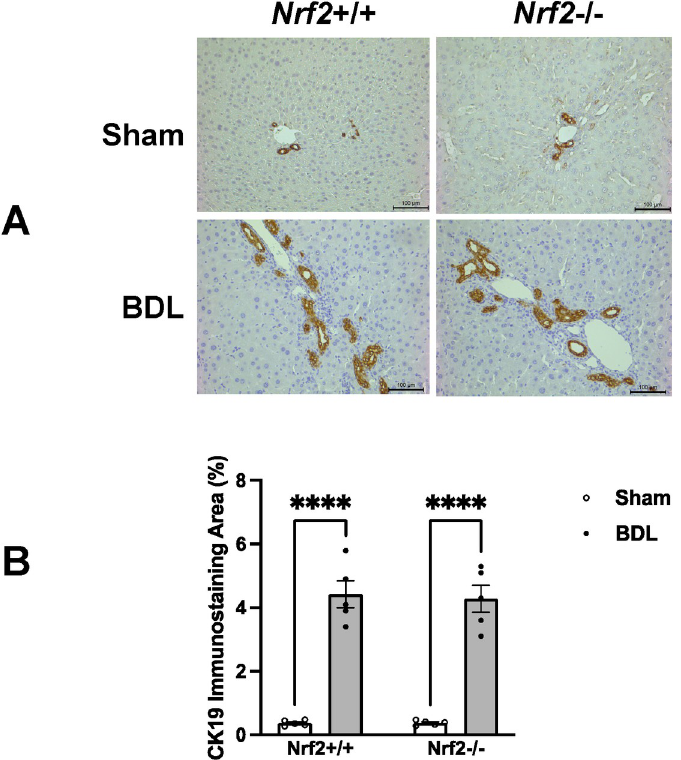
Fig 3. Hepatic distribution of CK19+ cells in Nrf2 +/+ and Nrf2 -/- mice following bile duct ligation (BDL) or sham operation (Sham). Sections were prepared from the livers of mice 40 days after BDL or sham operation and subjected to CK19 immunostaining. (A) Representative sections show CK19 + cells stained dark brown within the biliary ducts. (B) The percentages of CK19 + areas. Data are presented as mean percentage ± SEM (n = 5). ���� , P < 0.0001.